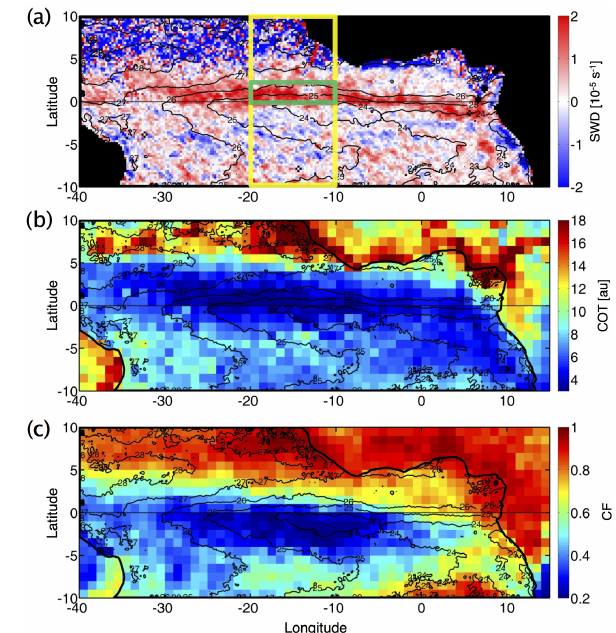
Figure 4. Monthly mean maps of (a) surface wind divergence (in units of 10 − 5 s − 1 ), (b) cloud optical thickness (in arbitrary units), and (c) daytime cloud cover fraction (normalized units between 0 and 1) during July 2007. SST ( ◦ C) is presented as black contours in all panels. The yellow and green boxes in Fig. 4a define the areas focused on in Figs. 5 and